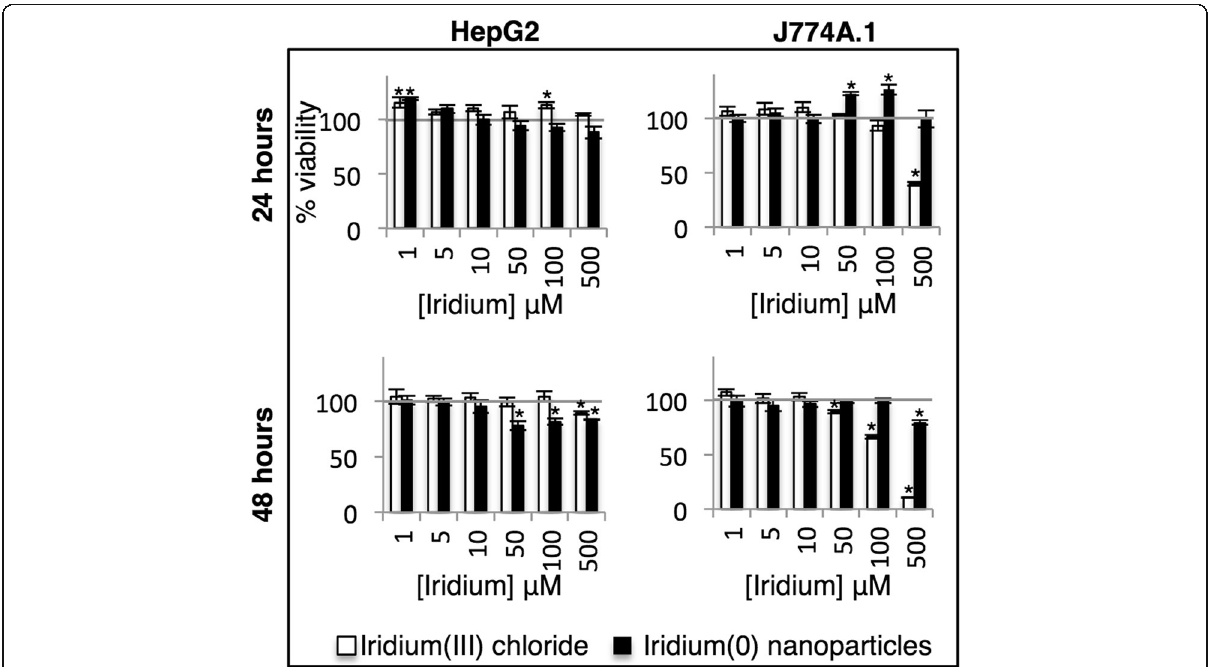
Fig. 4 Cellular viability of HepG2 and J774A.1 cells incubated with Ir(0) nanoparticles or Ir(III) salt for 24 or 48 h. *Statistically significant values ( p < 0.05) relative to untreated